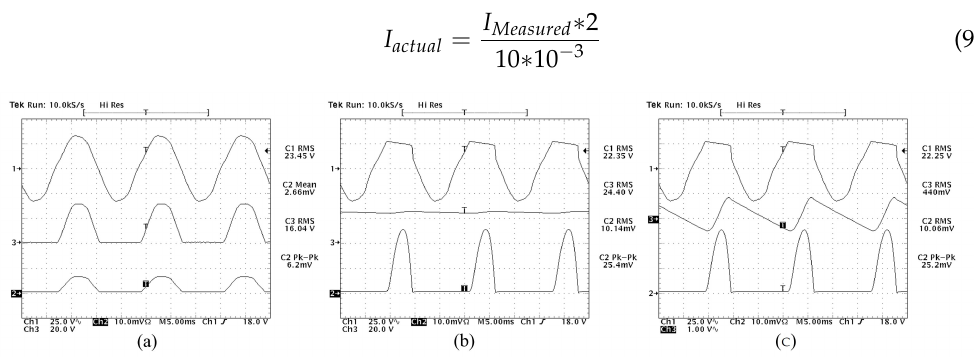
Figure 7. Experimental results of half − wave rectification: ( a ) without output capacitor ( b ) with output capacitor ( c ) the voltage ripples and DC